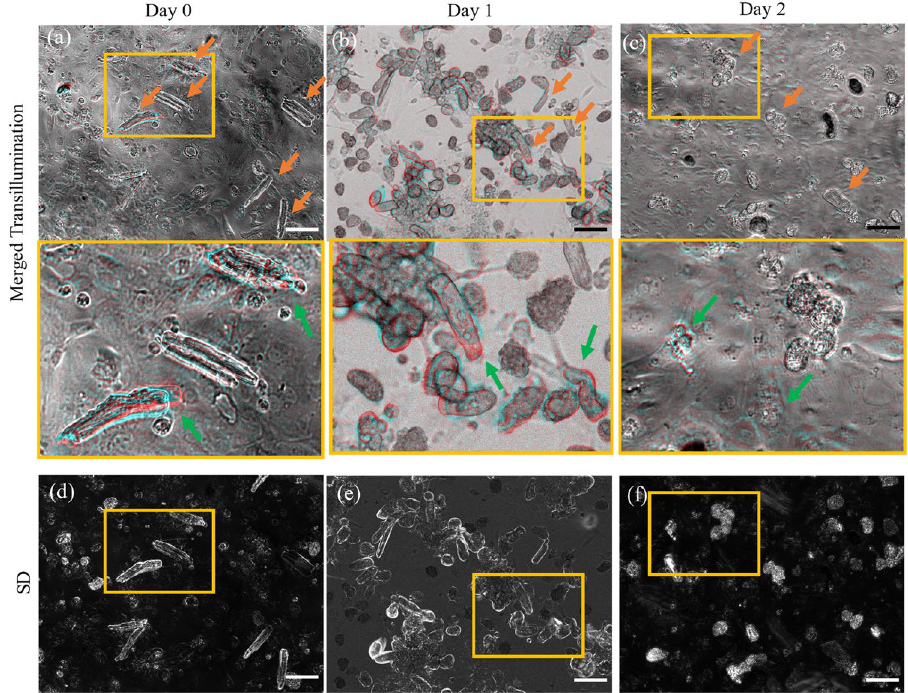
Figure 3. Synchronized contraction between spatially separated adult-CM in day 0, 1, 2 co-culture imaged under widefield transillumination. ( a–c ) Top images show two merged frames: at peak of contraction (cyan), and at baseline (red), taken t = 2.5 s apart for samples on ( a ) day 0, ( b ) day 1 and ( c ) day 2 of co-culture. Orange arrows indicate some of the adult cardiomyocytes on top of the layer of hiPSC CM co-culture. ( a–c ) Bottom row shows zoomed in ROI indicated by the yellow rectangles in the top row, with green arrows pointing out some of the contraction movement between the merged frames (see Supplementary Video 2 for 50 s timelapse). ( d–f ) Images for days 0, 1, and 2, calculated as the standard deviation across the whole acquisition, indicating movement during acquisition. The yellow rectangles indicate the zoomed in ROI shown in the bottom row of ( a–c ). Scalebar: 100